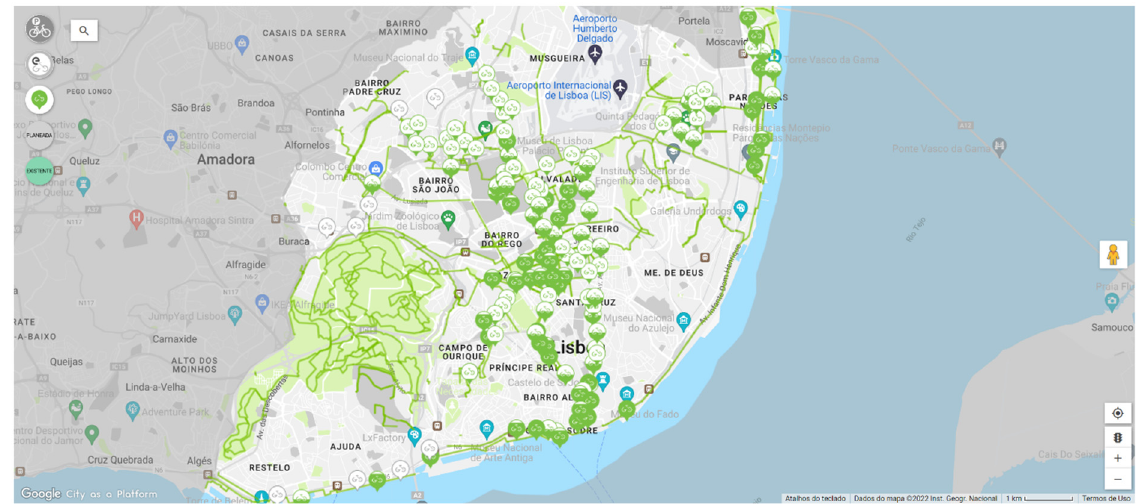
Figure 2. GIRA system spatial coverage. Bike lanes in green lines (circa 100 km).